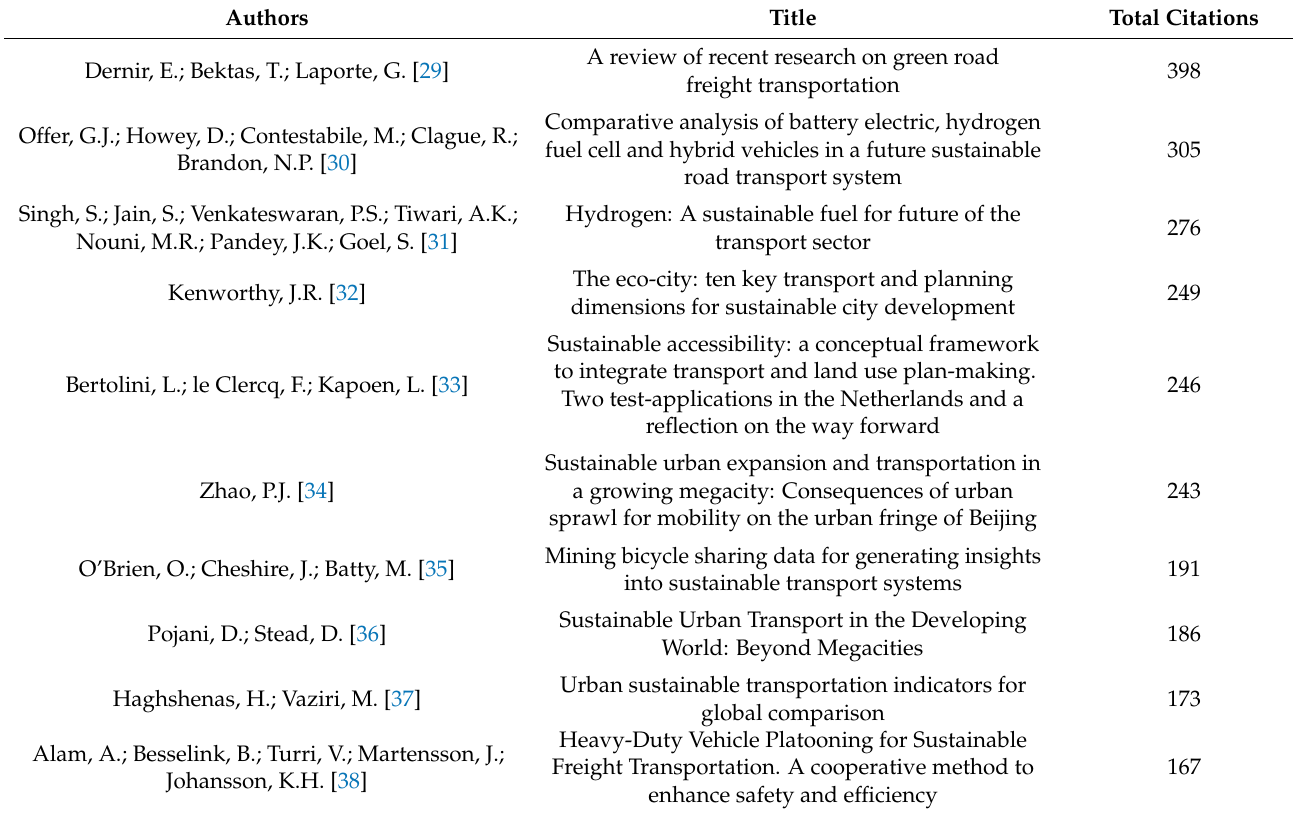
Table 3. Top ten cited papers in sustainable transport